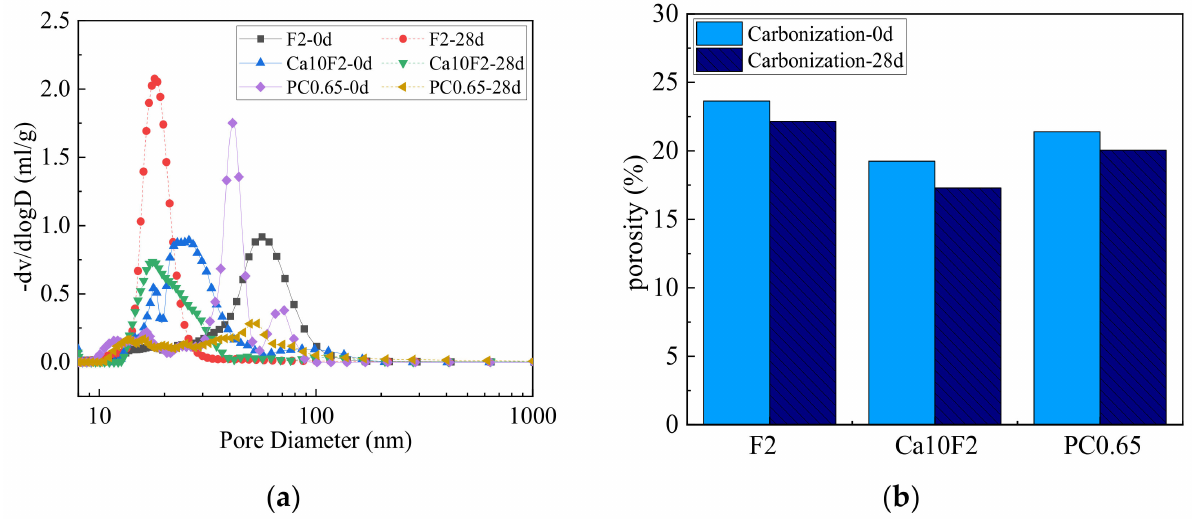
Figure 6. Effect of carbonization on geopolymers and cement pore structure. ( a ) Aperture distribution variation; ( b ) Porosity